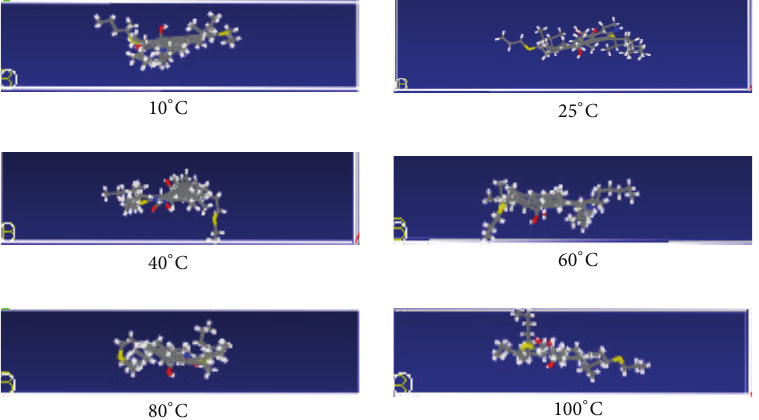
Figure 3: The configuration of asphaltene molecules in different